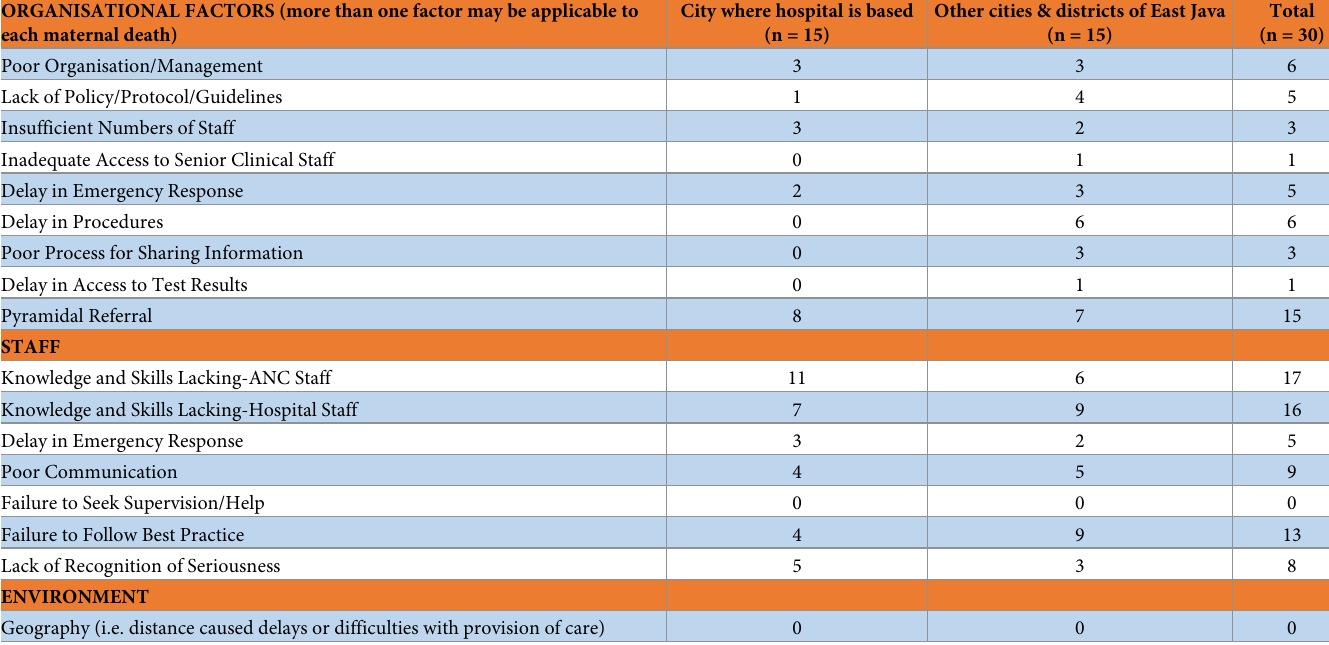
Table 2. Health services organisational, staff and personal factors (How the women were managed by the system–not only by the peak hospital). ORGANISATIONAL FACTORS (more than one factor may be applicable to each maternal